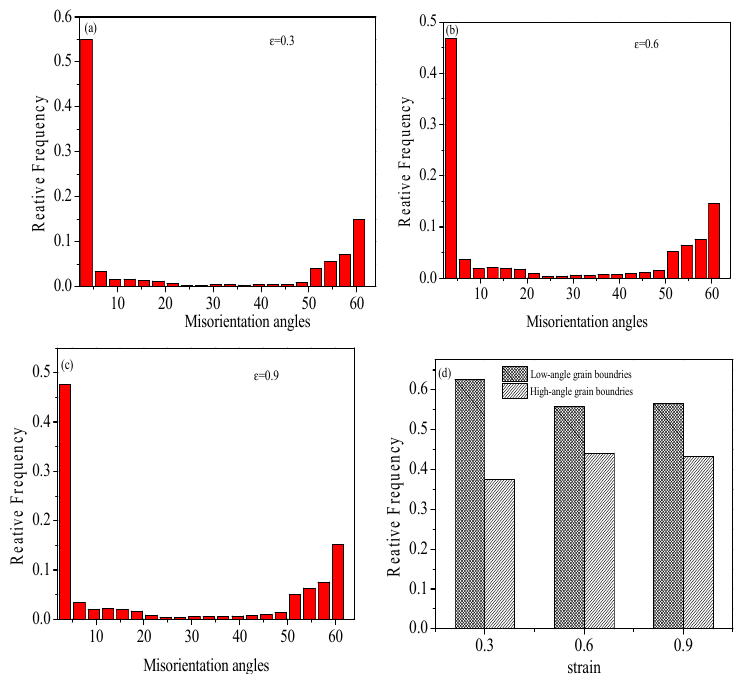
Figure 11. EBSD maps of the hot compressed specimens of H13-mod steel at the deformation temperature of 1100 °C, strain rate of 0.01 s − 1 and true strain of ( a ) 0.3; ( b ) 0.6; ( c ) 0.9. Metals 2018 , 8 , x FOR PEER REVIEW